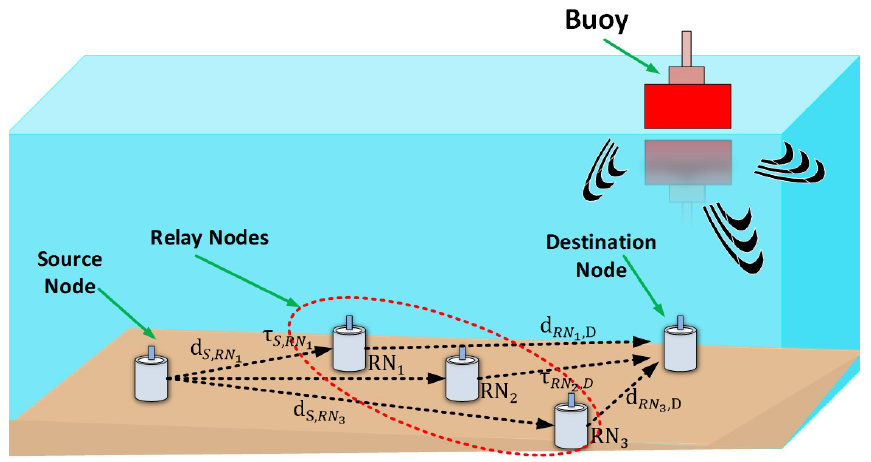
Figure 1. Network layout of cooperative communication for